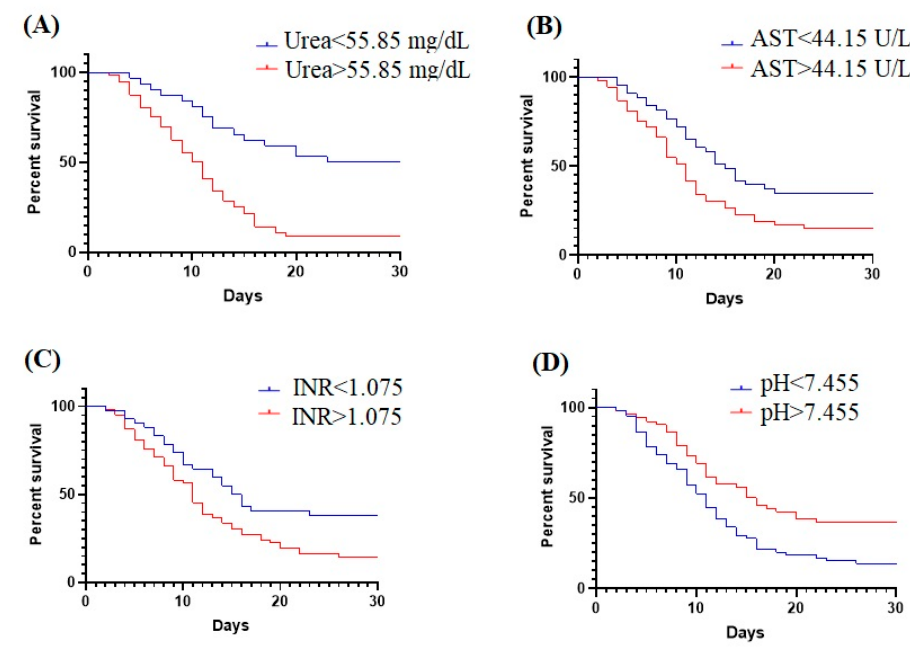
Figure 3. Kaplan-Meier curves for ( A ) urea; ( B ) AST; ( C ) INR; ( D ) pH.